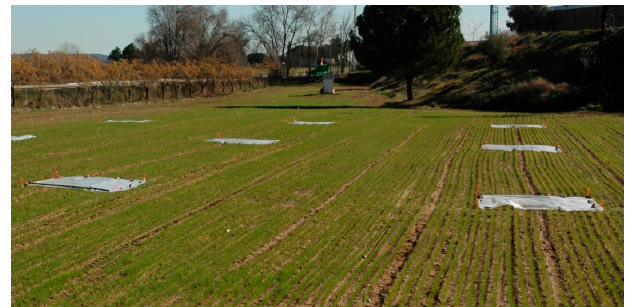
Figure 8. Winter cereal field prepared with nine seeded weed patches.